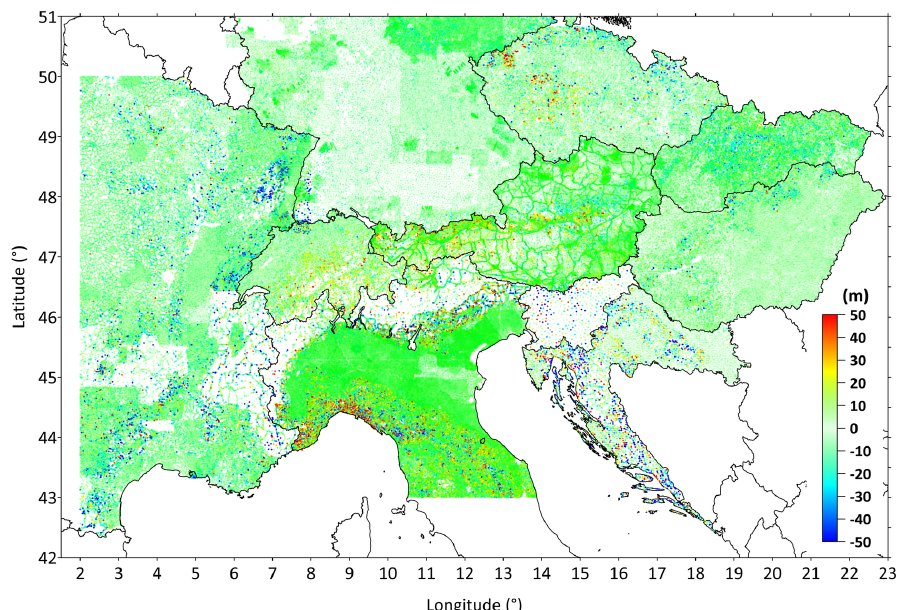
Figure C4. Height differences (in meters) between MERIT DEM heights and heights of original surface-gravity stations; MERIT DEM heights were considered for the “middle zone” of the mass calculation software TOPOSK (refer to Appendix D).